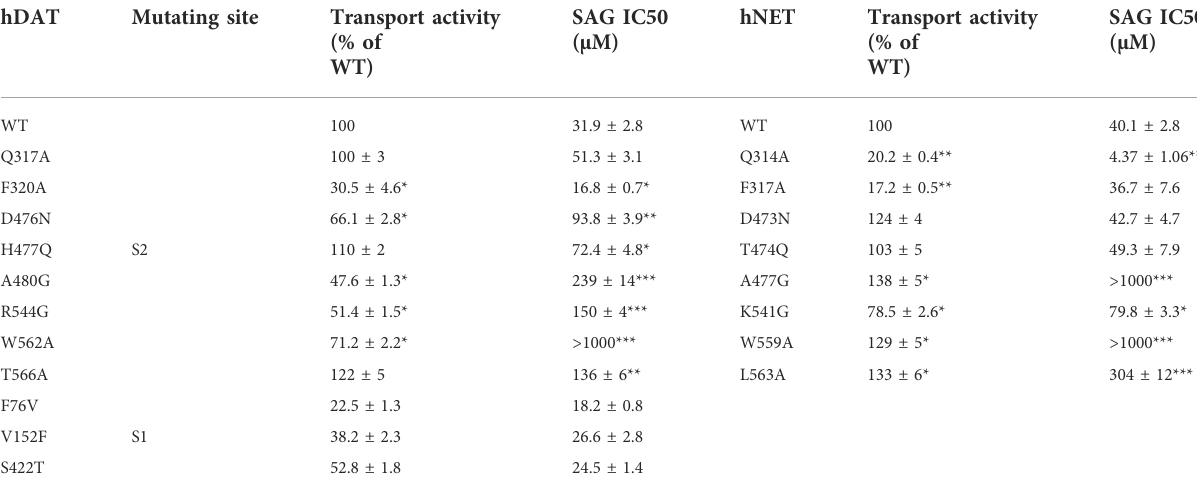
TABLE 2 Inhibition potency of SAG for WT and mutants of hDAT and hNET. APP + transport was performed on intact HeLa cells transiently expressing WT or allosteric and orthosteric mutants of hDAT and hNET as described underTable 1. The APP + uptake rate without SAG addition for WT-hDAT and WT-hNET were 36.23 ± 1.91 mean AFU/min and 33.91 ± 2.23 mean AFU/min,